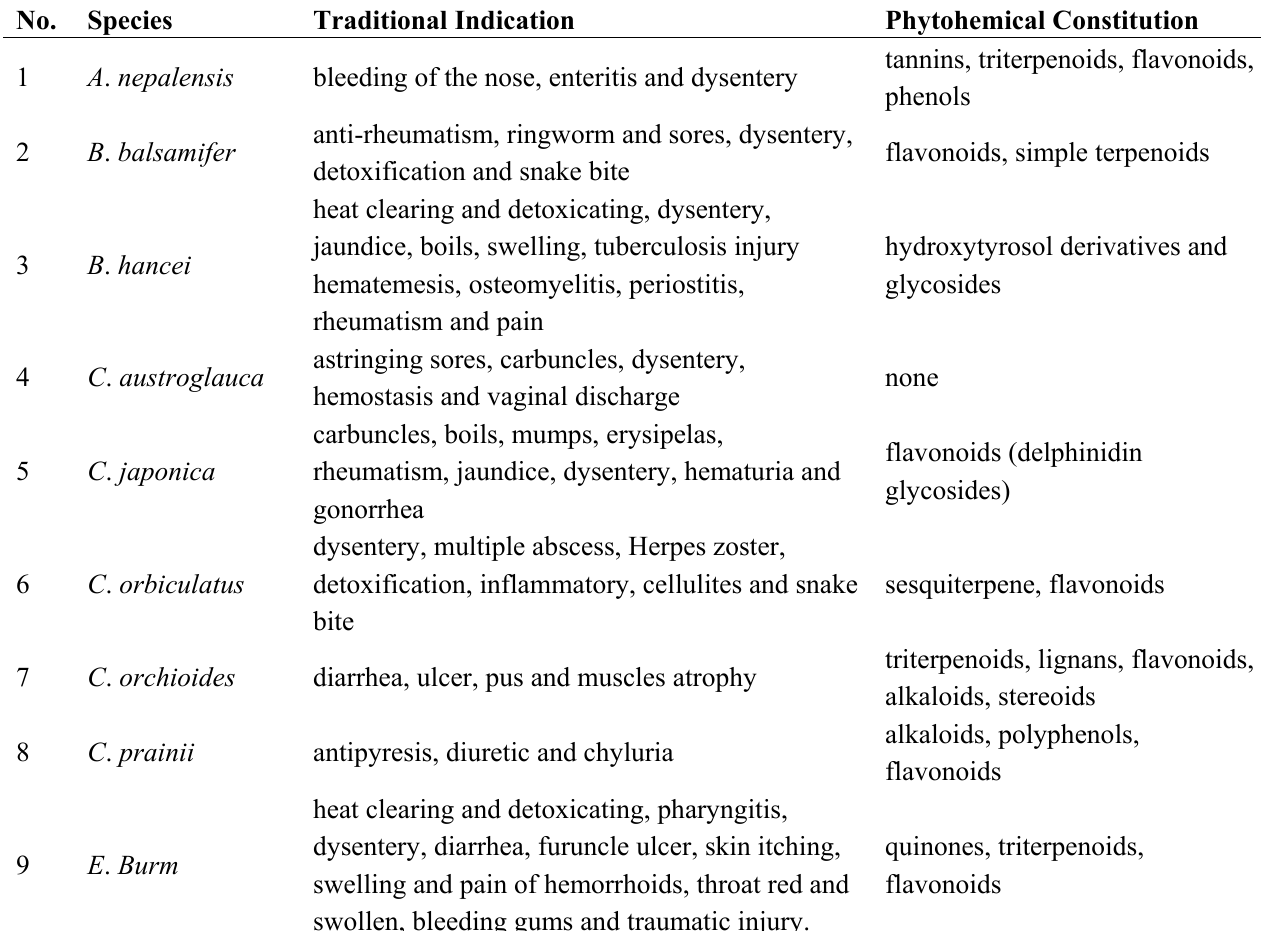
Table 1. Traditional indications and phytohemical constitution of the 30 Chinese plants.